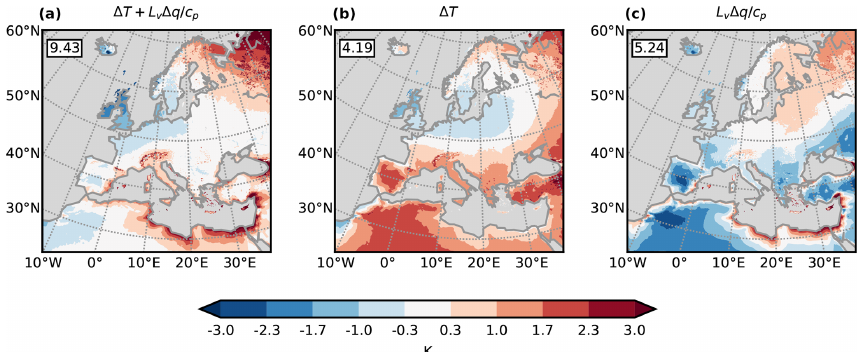
Figure 6. Decomposition of the anomaly of surface moist enthalpy ( H ) changes in the 0.11 ◦ EURO-CORDEX ensemble for the summer season over land. (a) Overall anomaly (deviation from the domain mean) of the change in moist enthalpy, normalized by the specific heat of air ( c p ) to yield the unit kelvin. Thus, the surface moist enthalpy change has been computed as (cid:49)H = (cid:49)T + L v (cid:49)q/c p . The anomalies of the two components of H are shown separately. Panel (b) shows the anomaly of (cid:49)T , while panel (c) shows the anomaly of L v (cid:49)q/c p . Gray shading shows ocean areas which are masked to improve the